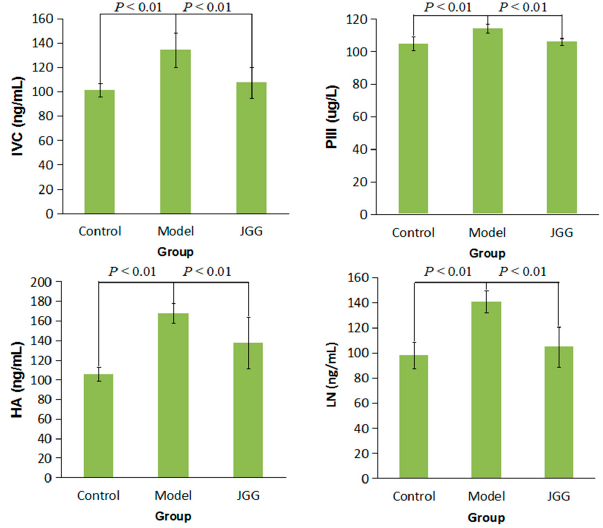
Figure 1. Effect of JGG on serum levels of CIV, PCIII, HA and LN in CCl 4 -induced liver fibrosis rats. Value are expressed as x(cid:3364) ± S.